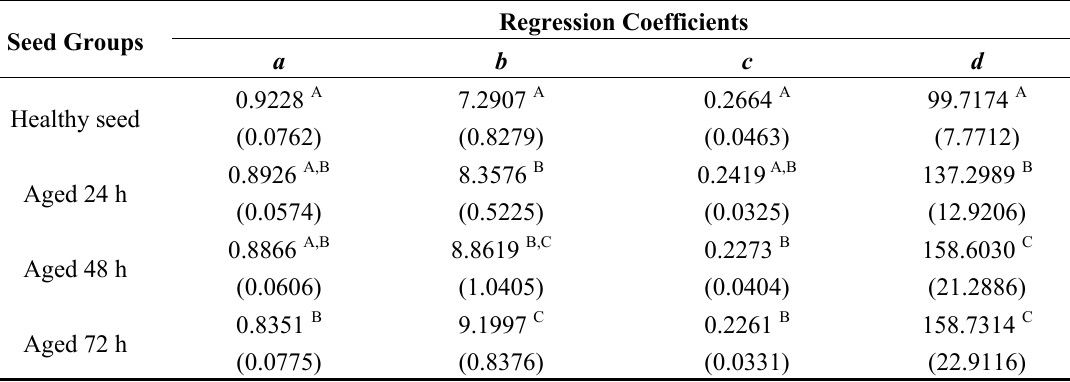
Table 1. Averaged regression coefficient for lettuce seeds aged for 0, 24, 48, or 72 h.